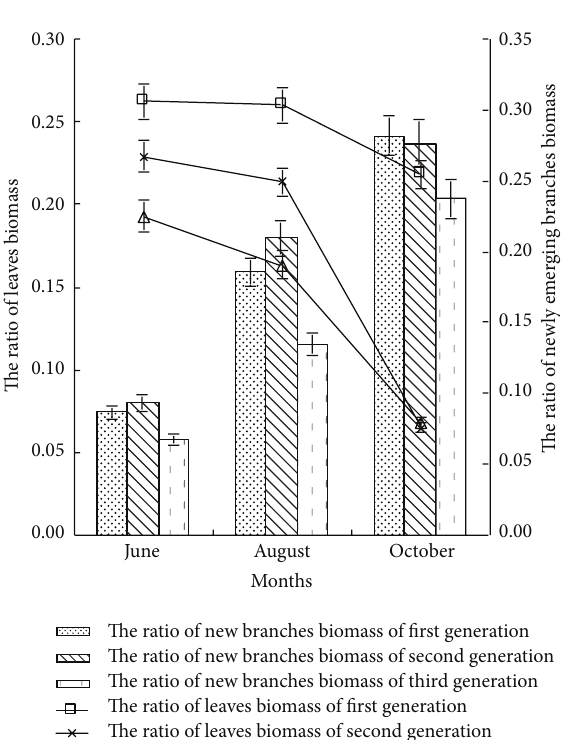
Figure 5: The ratio of leaves and newly emerging branches biomass of poplar under different continuous croppings.